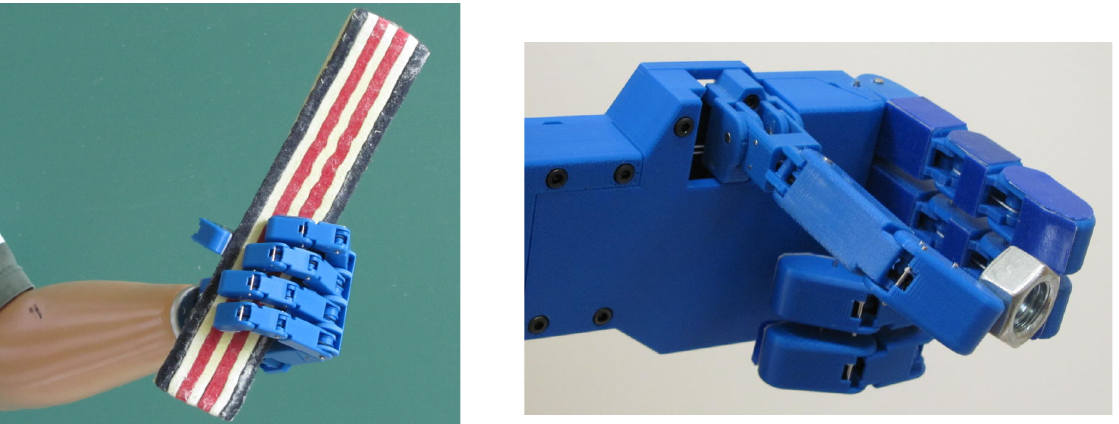
Figure 12. The prosthetic hand grasping a tennis ball with an en- veloping grasp.